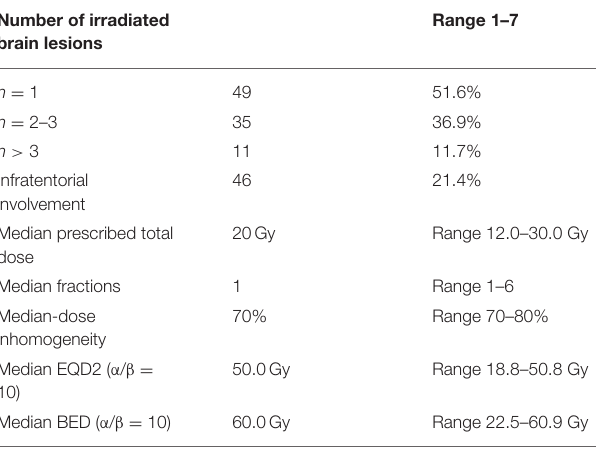
TABLE 5 | Treatment characteristics ( n =